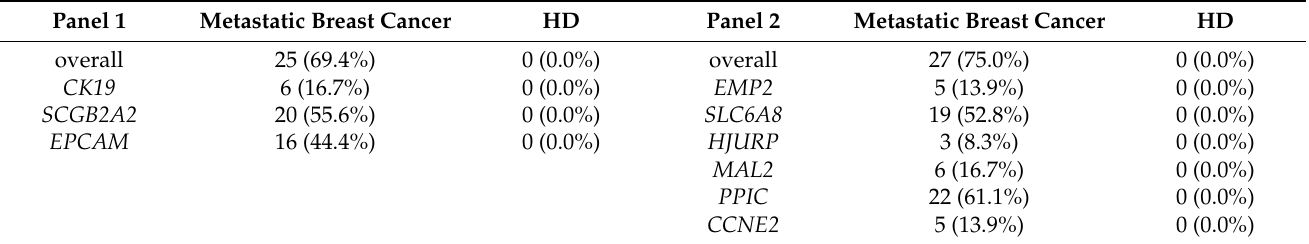
Table 1. Positivity rate of the CTC-related gene markers in metastatic breast cancer patients (n = 36) and HD (n = 9) after applying a cut-off threshold value. The positivity rates are given for each marker individually and for overall Panel 1 and Panel 2. For the definition of positive patient sample, a threshold was set in order to allow a maximum of 10% positive findings in the HD